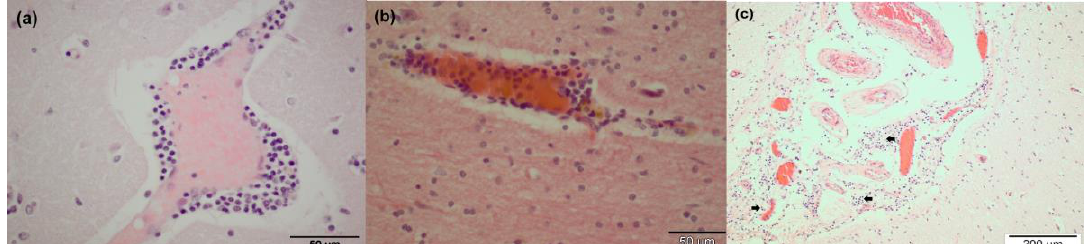
Figure 1. Histopathology (Grevy’s zebra, CG3) showing non-suppurative encephalitis represented by mononuclear perivascular cuffs in the gray matter of the cerebral cortex ( a ) and forebrain ( b ); Hematoxilin – eosine (HE) staining. Meningeal perivascular infiltration of inflammatory cells (arrows) ( c ); HE staining.